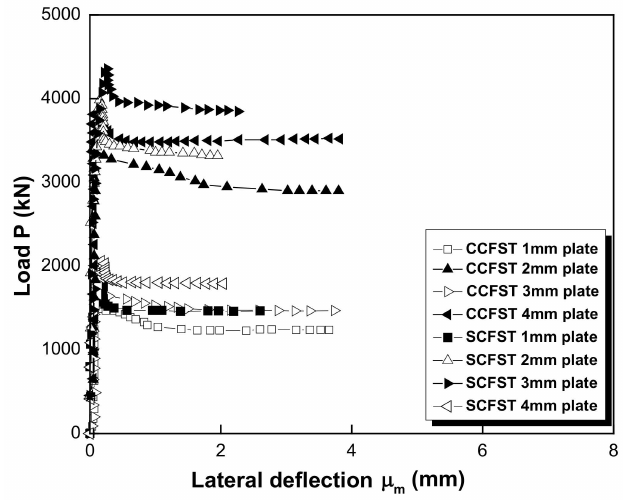
Figure 9. Axial load (P)-lateral deflection (u m ) of the CCFST and SCFST models with different cross-shaped